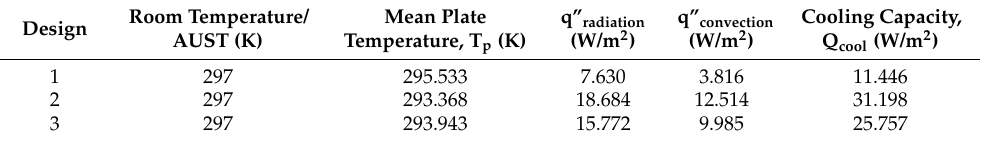
Table 9. Radiant cooling panel cooling